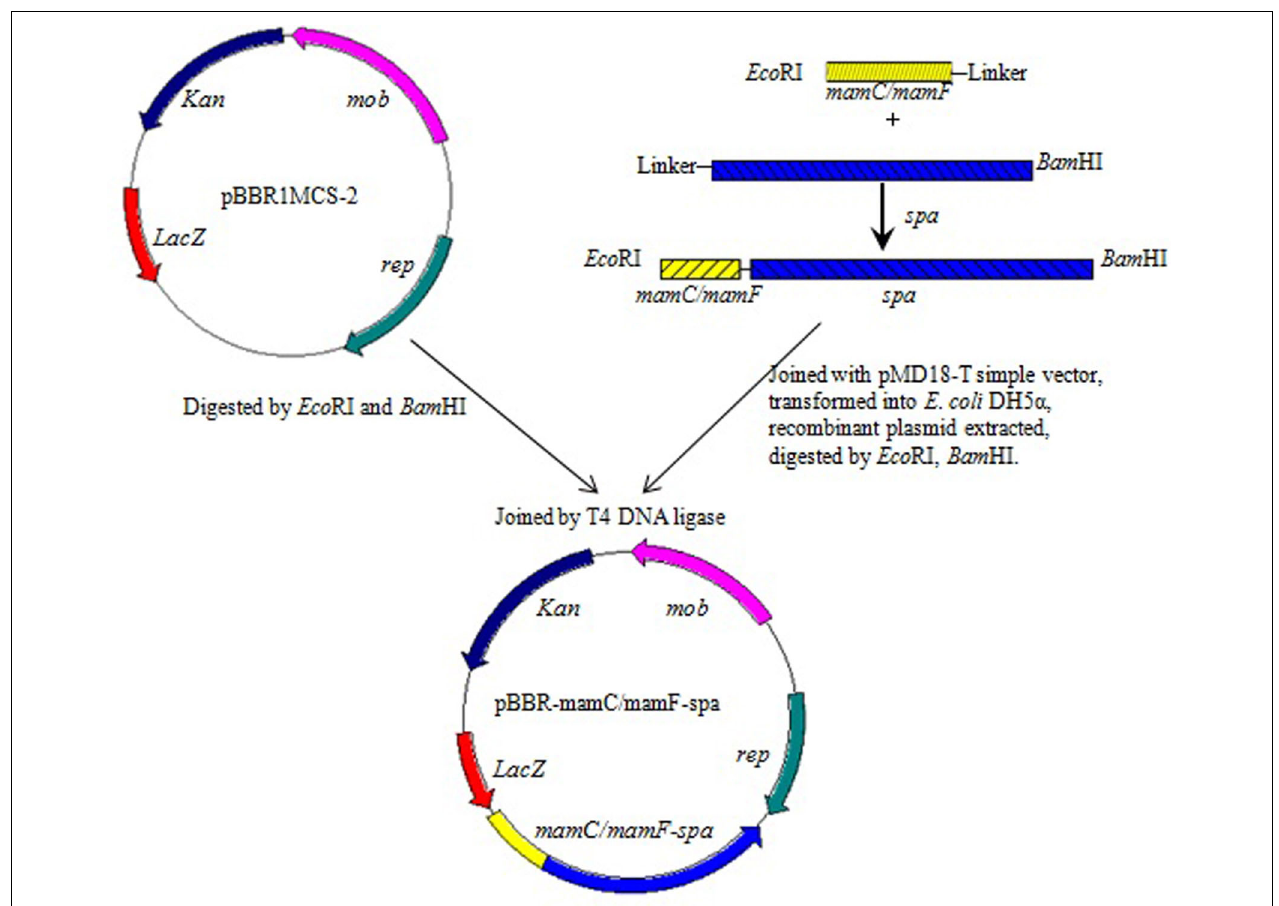
FIGURE 1 | Construction of plasmids pBBR-mamC-spa and